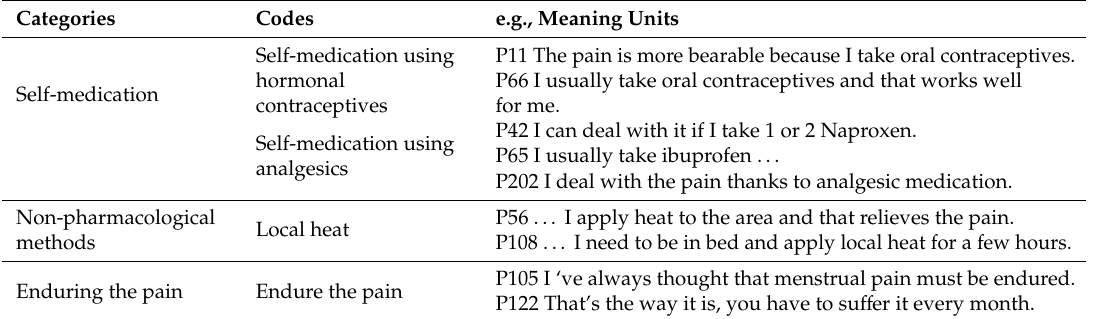
Table 5. Categories, codes and examples of the topic “A preference for